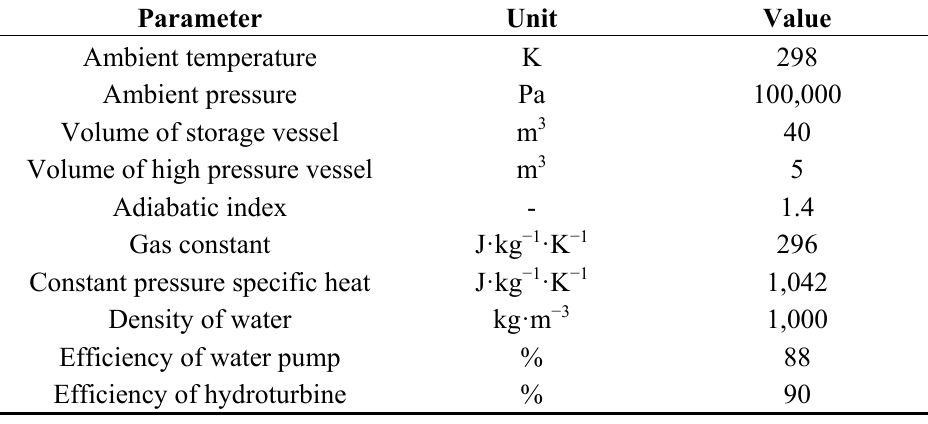
Table 1. Main parameters and their values of constant-pressure PHCA